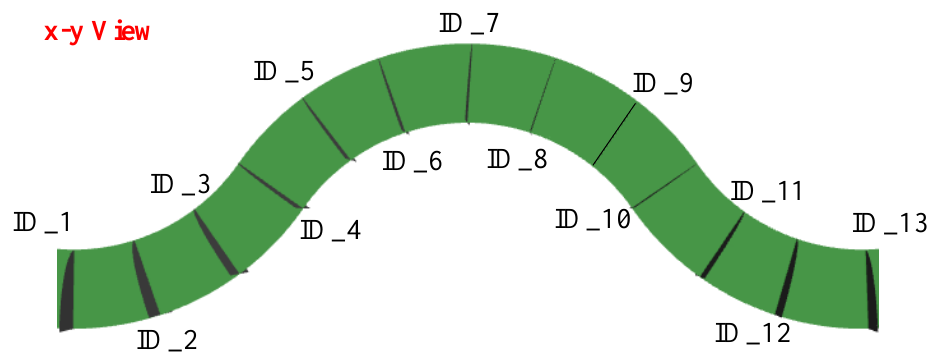
Figure 17. The cross-section diagram.